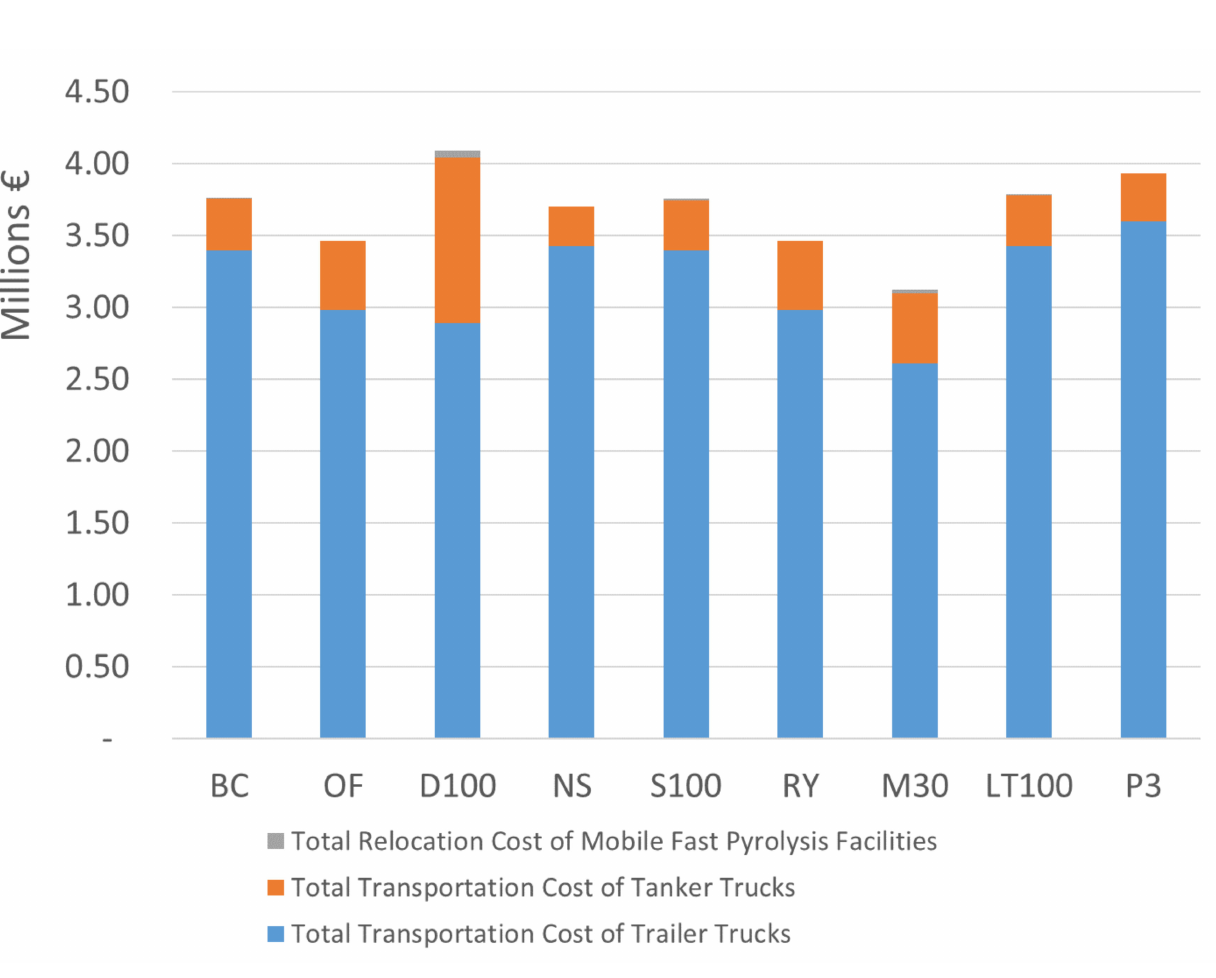
Figure 6. Transportation cost